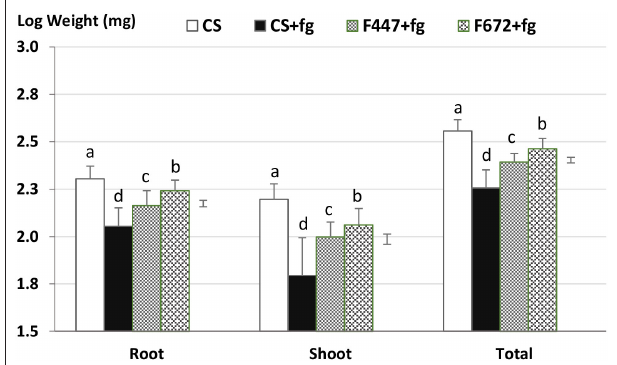
FIGURE 4 | Quantification of viable conidia produced from MS-DE coated on maize seeds. The final entomopathogenic fungal loading on maize seeds after seed coating with MS granules was determined as colony forming units (CFU) per gram of coated seeds; LSD 5 % = 4.6 × 10 6 , p < 0.05. Error bars = standard error.